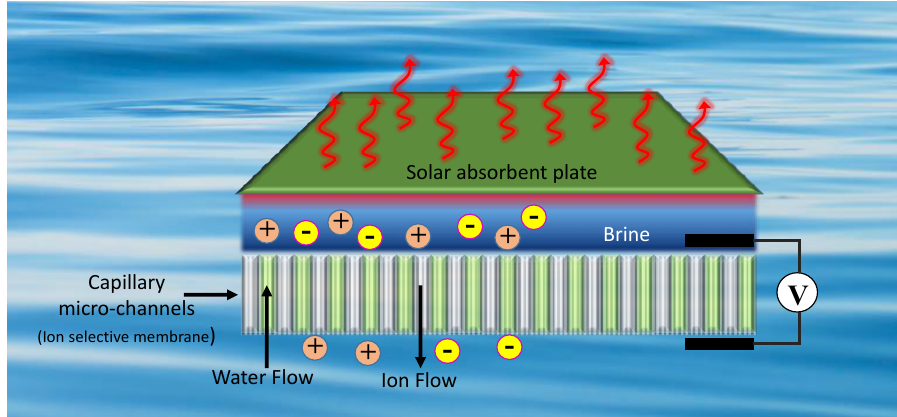
Figure 12. Schematic design of capillary-driven desalination / energy harvesting.